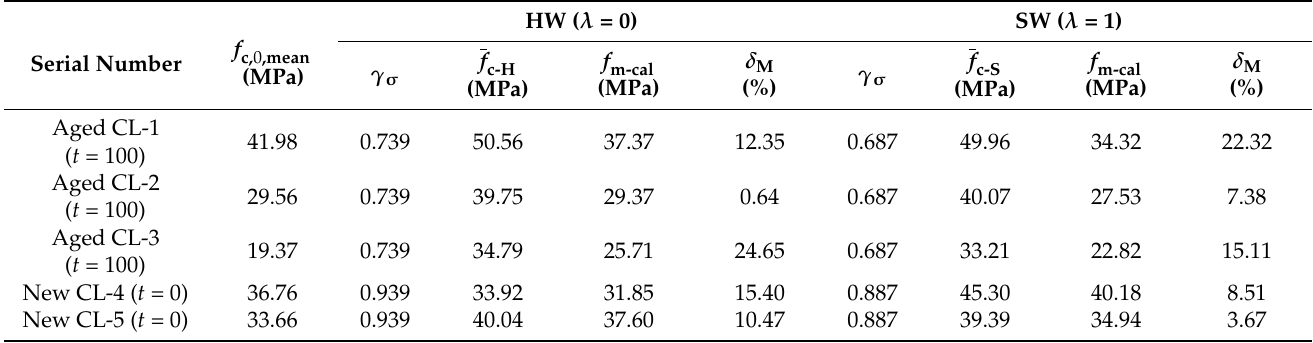
Table 5. Estimation of compressive strength of the log samples using Equation (6).